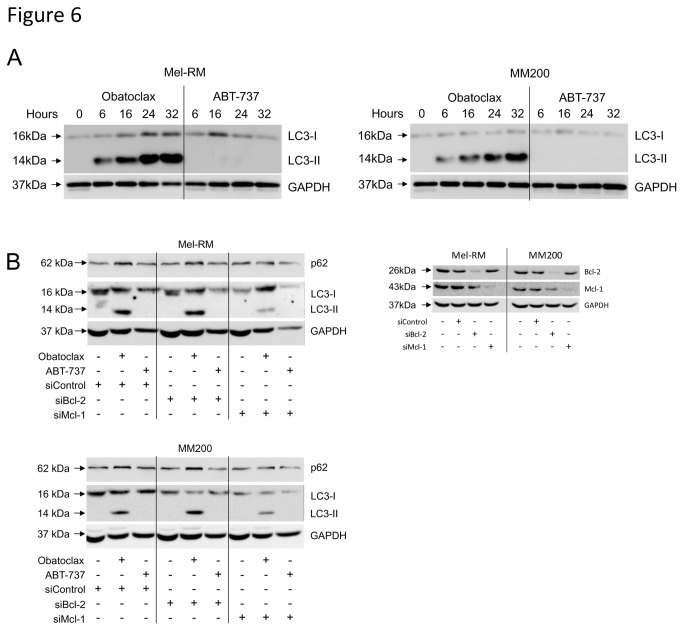
Induction of autophagy by BH3 mimetics.A. Mel-RM and MM200 cells were treated with Obatoclax (1µM) or ABT-737 (10µM) for indicated times. Whole cell lysates were collected and subjected to Western blot analysis for LC3 protein levels. The cytosolic form, LC3-I, is expressed as a 16kDa protein, which is lipidated and bound to autophagosome membranes, resolving as a 14kDa form, LC3-II. Data are representative of three individual experiments.B. Mel-RM and MM200 cells were transfected with either control, Bcl-2 or Mcl-1 siRNA before treatment with either Obatoclax (1µM) or ABT-737 (10µM) as indicated for 16 hours. Whole cell lysates were collected and subjected to Western blot analysis for Mcl-1 and Bcl-2, to confirm knockdown efficiency, and LC3 and p62 to investigate induction of autophagy. Data are representative of two individual experiments.